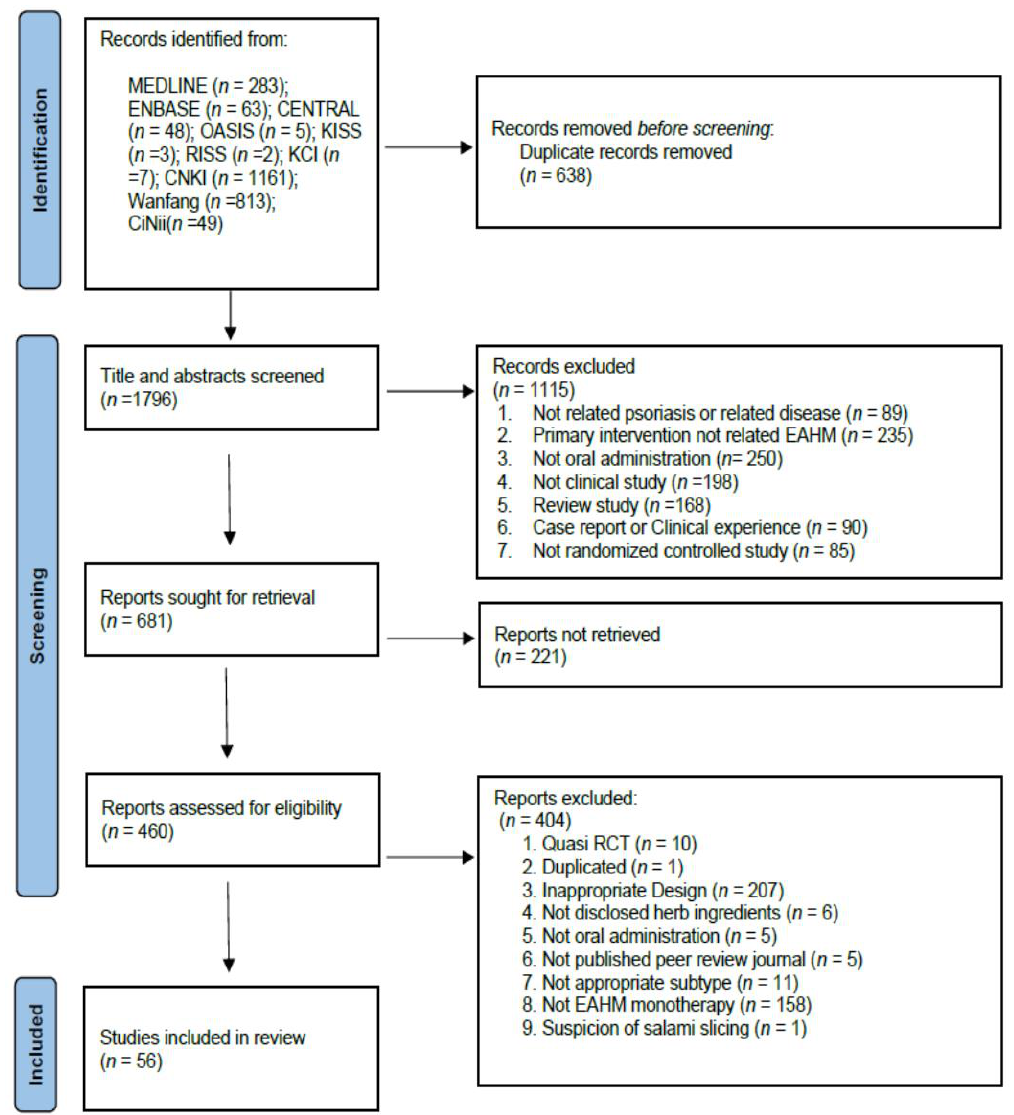
Figure 1. PRISMA 2020 flow diagram.